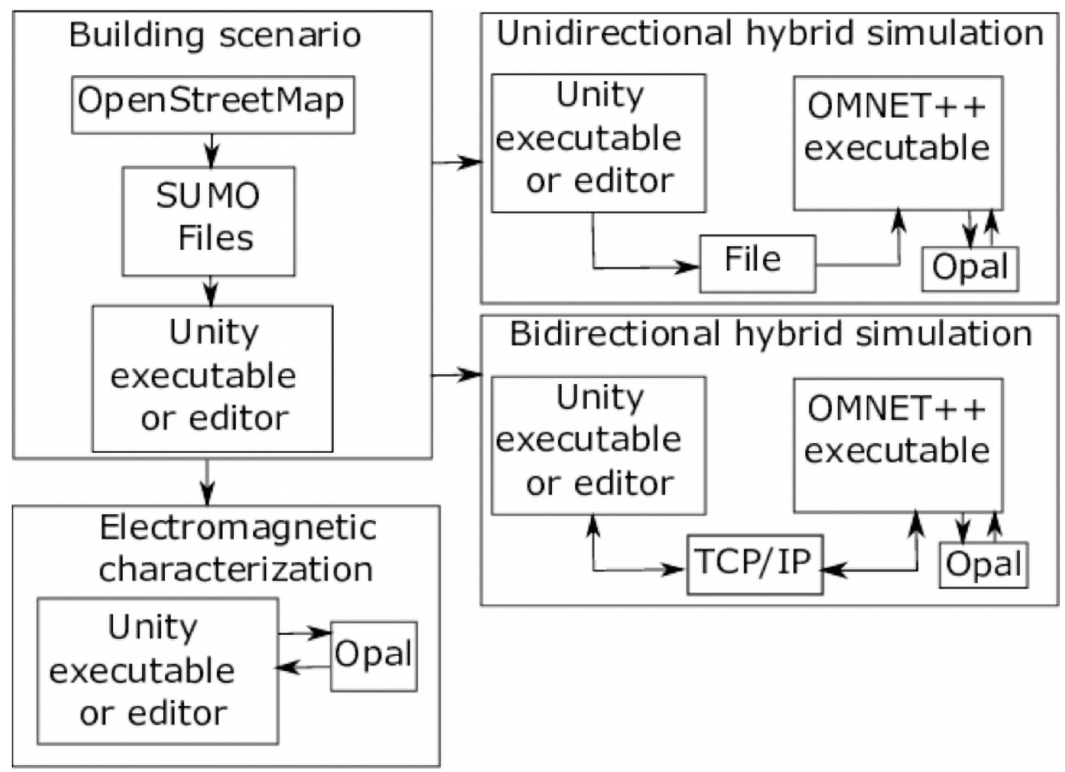
Fig 2. Workflow and types of simulations with Veneris and Opal. First, the scenario is built from real-world map data. Then, three alternatives are available: (1) to carry out the electromagnetic characterization of the scenario, just with Opal; (2) to run a unidirectional hybrid simulation, where the traffic simulation output is stored and then fed to the OMNET++ modules; (3) to run a bidirectional simulation, where traffic and network simulation are run simultaneously and interact with each other.